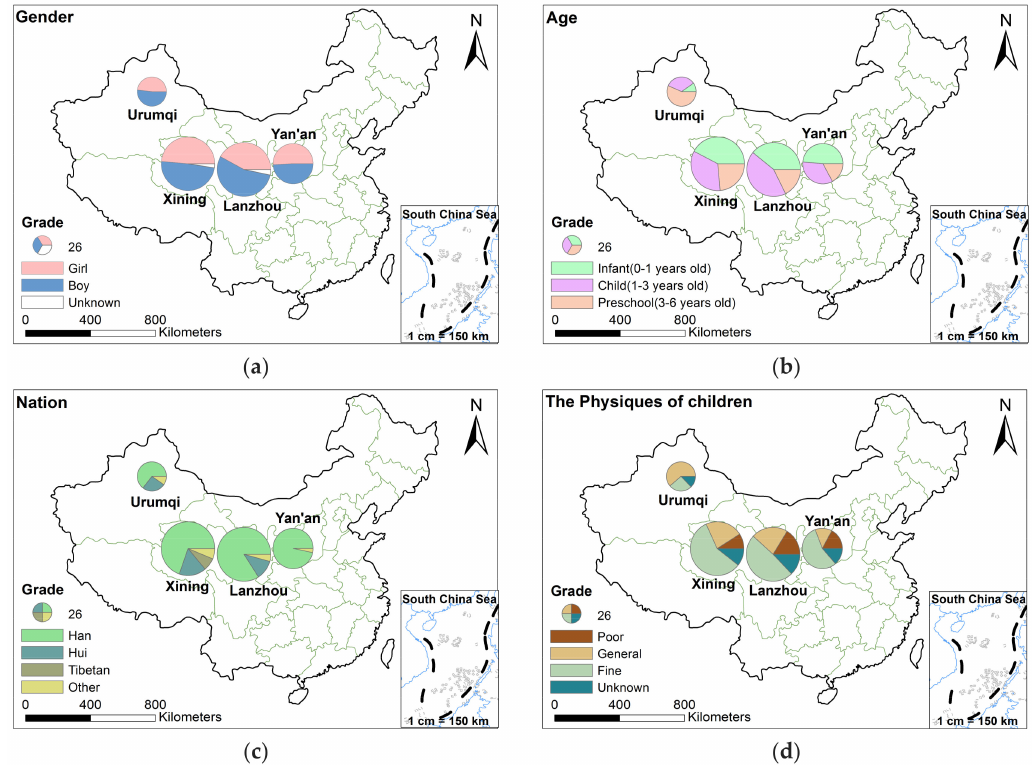
Figure 3. The basic situation of participants. ( a ) for child’s gender; ( b ) for child’s age; ( c ) for ethnic identity (nation); ( d ) for children’s